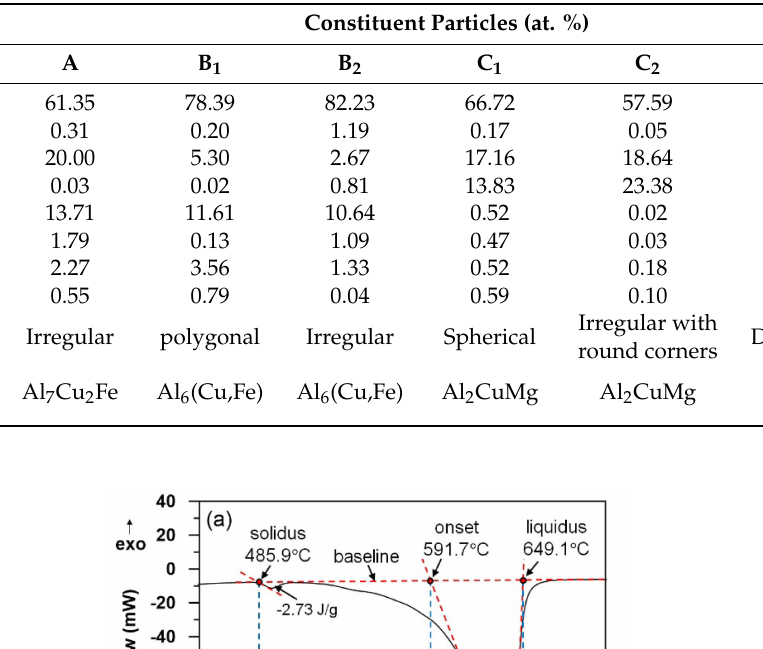
Table 2. Scanning electron microscope (SEM)/energy dispersive spectroscopy (EDS) analysis results of selected constituent particles highlighted in Figure 1.